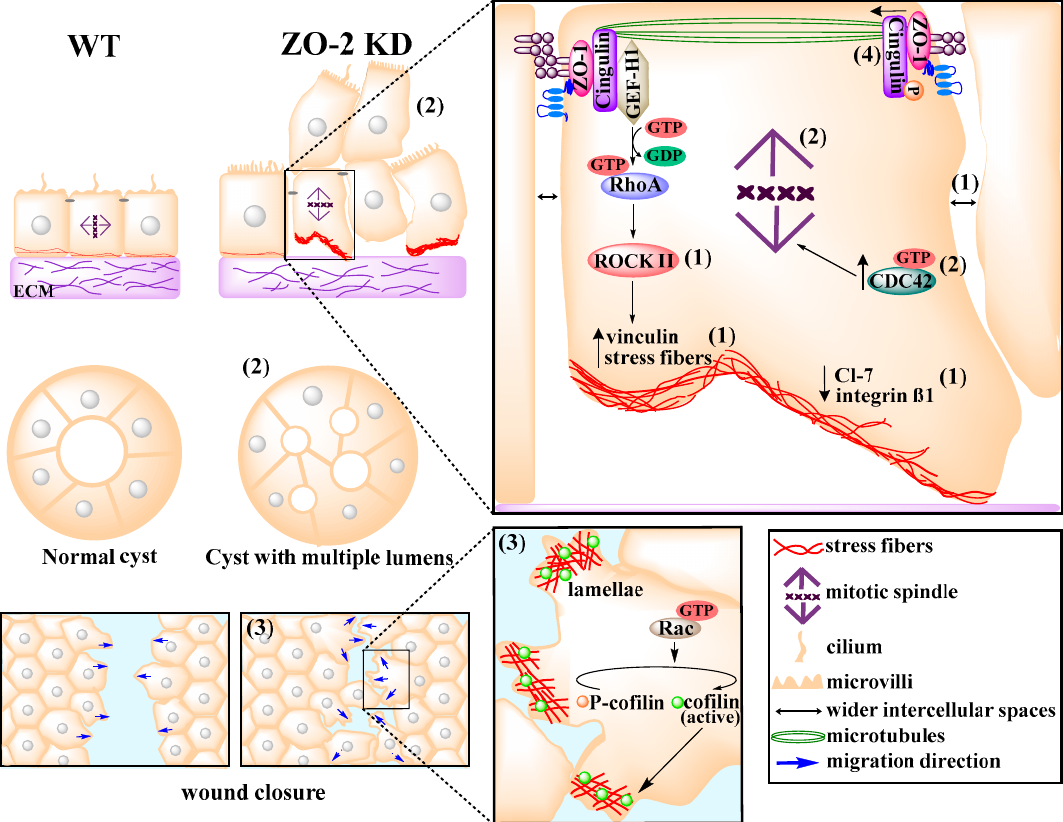
Figure 4. ZO-2 modulates cell size and tissue architecture. Absence of ZO-2 induces cell hypertrophy and development of an atypical cytoarchitecture characterized by: ( 1 ) Wider intercellular spaces and the detachment of cells from the substrate accompanied by a reduced expression of claudin-7 and integrin β 1, an increased recruitment of vinculin to focal adhesions, and the proliferation of stress fibers induced by RhoA / ROCK-II activation; ( 2 ) an augmented activation of CDC42 that triggers the disorientation of the mitotic spindle and leads to the growth of cells on top of each other in 2D and 3D cultures and then to the formation of multiple lumens per cyst; ( 3 ) the activation of Rac and cofilin, which promote the formation of multiple lamellipodia, reduce directional persistence, and increase wound closure; and ( 4 ) the disappearance of a planar network of microtubules at the cell border.